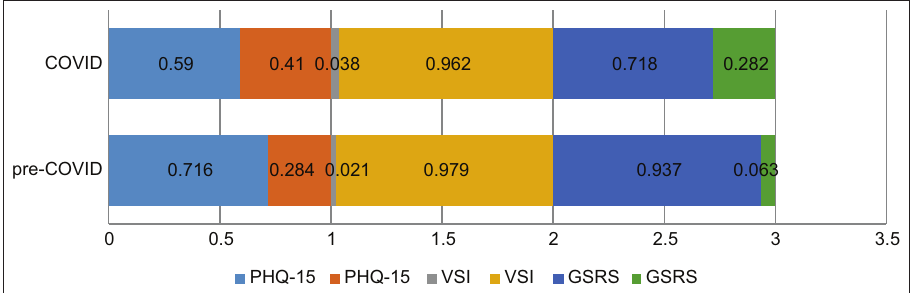
FIGURE 1. Frequency of symptom’s levels set by cutoff values (three for GSRS, 38 for VSI, and 10 for PHQ‑15) within the study groups, Group 1 (pre‑COVID time) and Group 2 (COVID time). TABLE 3. GSRS scores according to different gastronintestinal syndromes Groups